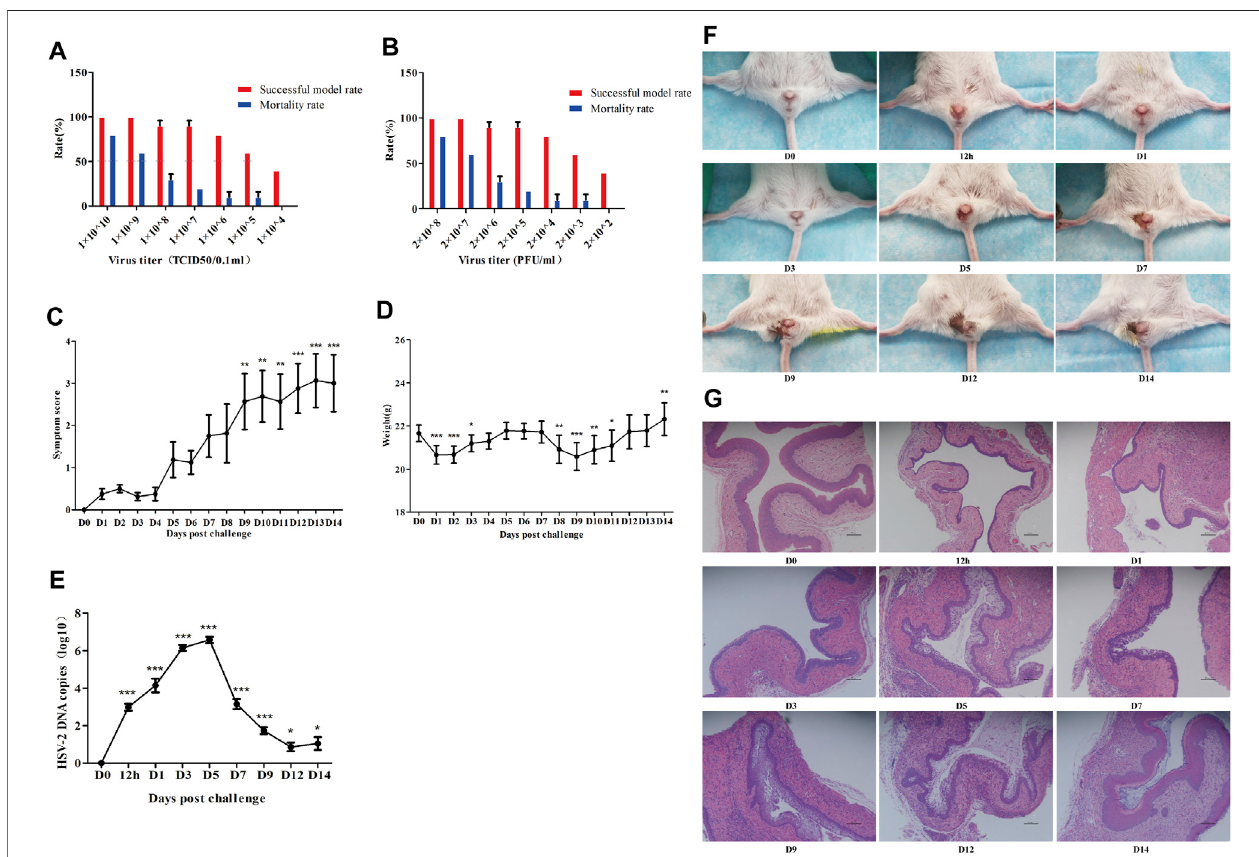
FIGURE 3 | Establishment of a mouse model of genital herpes. The model was established and optimized with multiple batches of mice. Successful model and mortality rates at different virus titers (A, B) were observed. Furthermore, symptoms score (C) , body weight (D) , viral load (HSV-2 gB mRNA) (E) , Symptom images (F) , vagina histomorphology ( × 100) (G) of mice at different time points after modeling were evaluated. D0: control group. 12 h: the 12 h after modeling. D1: the 1st day after modeling, et al. *p ＜ 0.05, **p ＜ 0.01, ***p ＜ 0.001 vs . D0 group.